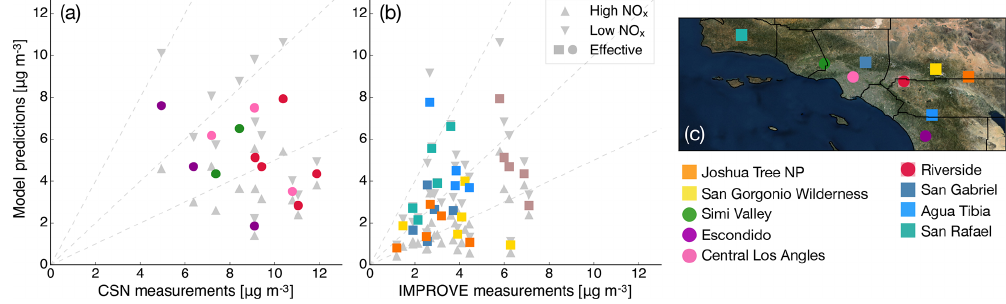
Figure 8. Model–measurement comparison for daily-averaged OA mass concentrations at (a) CSN and (b) IMPROVE sites in southern California. Panel (c) shows the geographic locations where the comparisons were